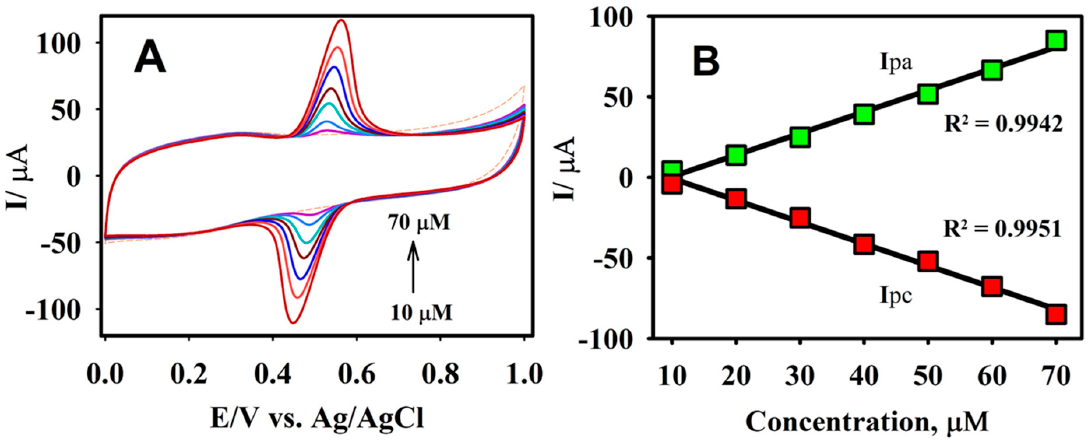
Figure 6. The CV responses of F-GO/GCE for the oxidation/reduction of CA at different concentrations, ranging from 10.0 to 70.0 µ M ( A ) and the corresponding plots of the anodic/cathodic peak current vs. the concentration of CA ( B ) in a 0.1 M B-R buffer solution pH 2.65, at a scan rate of 50 mV s − 1 .